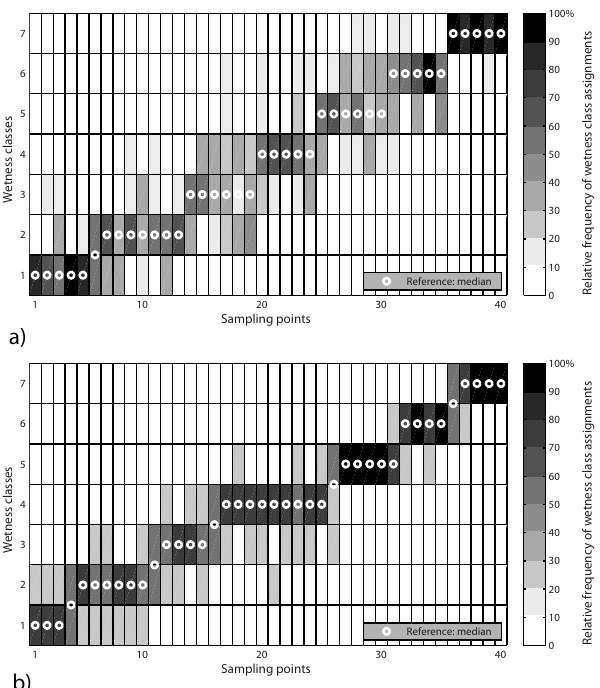
Figure 7. Spread of classification assignments for sampling points of individual wetness classes by (a) S basic with basic introduction and (b) S trained with additional training during test in April (grey shades: relative frequency of wetness class assignments for each of the sampling points, white circles: median of classifications). For example, sampling point 10 in panel (b) : the majority (50%) of raters classified this point as class 2 (white circle) but 25% of the raters assigned class 1 and 25% of the raters assigned class 3. Note that the sampling points were distributed in random order of wet- ness classes in the field experiment, but were ordered here accord- ing to the median estimation for graphical